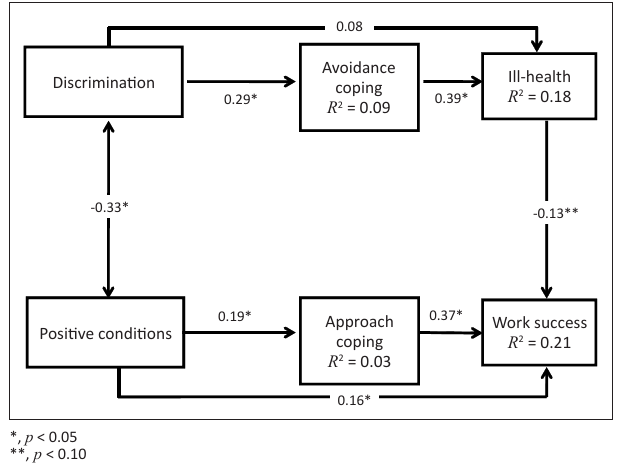
FIGURE 1: The results of the structural equation model analysis of the dual- process model.